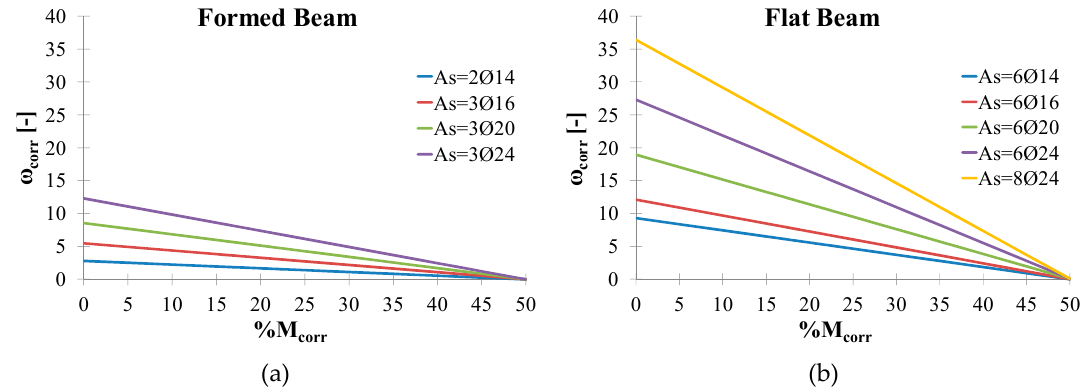
Figure 5. Decay of the mechanical reinforcement percentage with the corrosion levels. ( a ) formed beam; ( b ) flat beam.